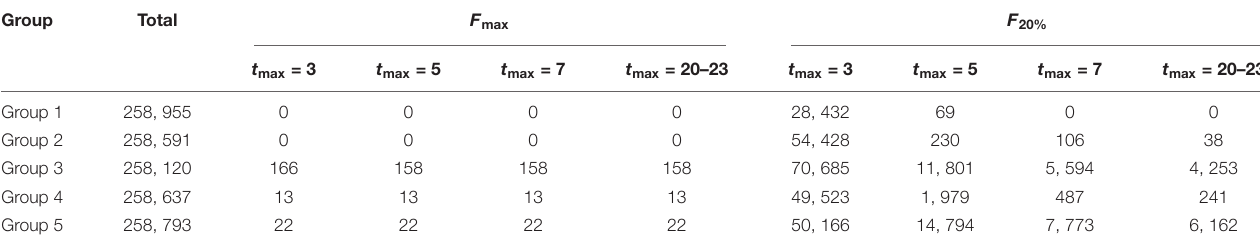
TABLE 1 | Number of the total parameter sets in per-recruit analysis and number of the parameter sets failing to define F max and F 20% . Group Total F